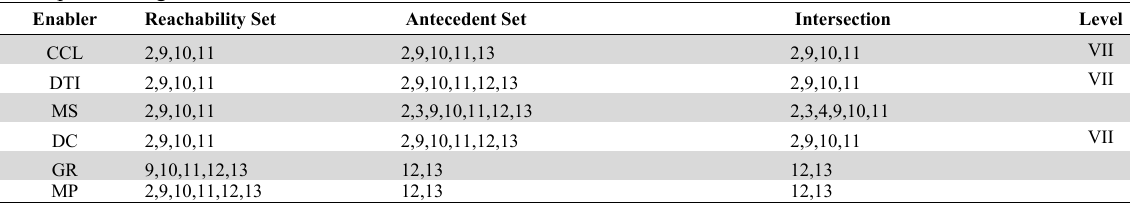
Level partitioning Iteration 7 Enabler